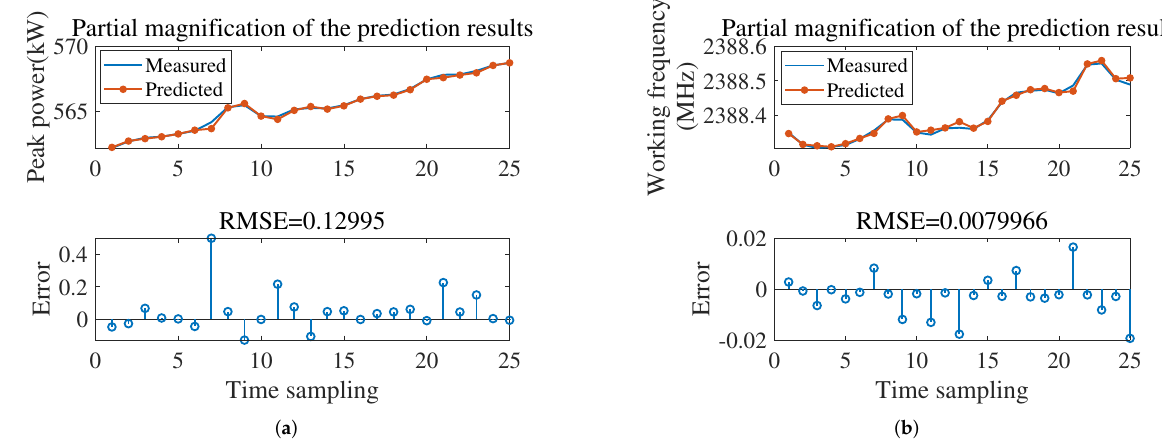
Figure 10. Partial magnification of prediction results and RMSE of the second type of degradation malfunction. ( a ) Peak power. ( b ) Working frequency.